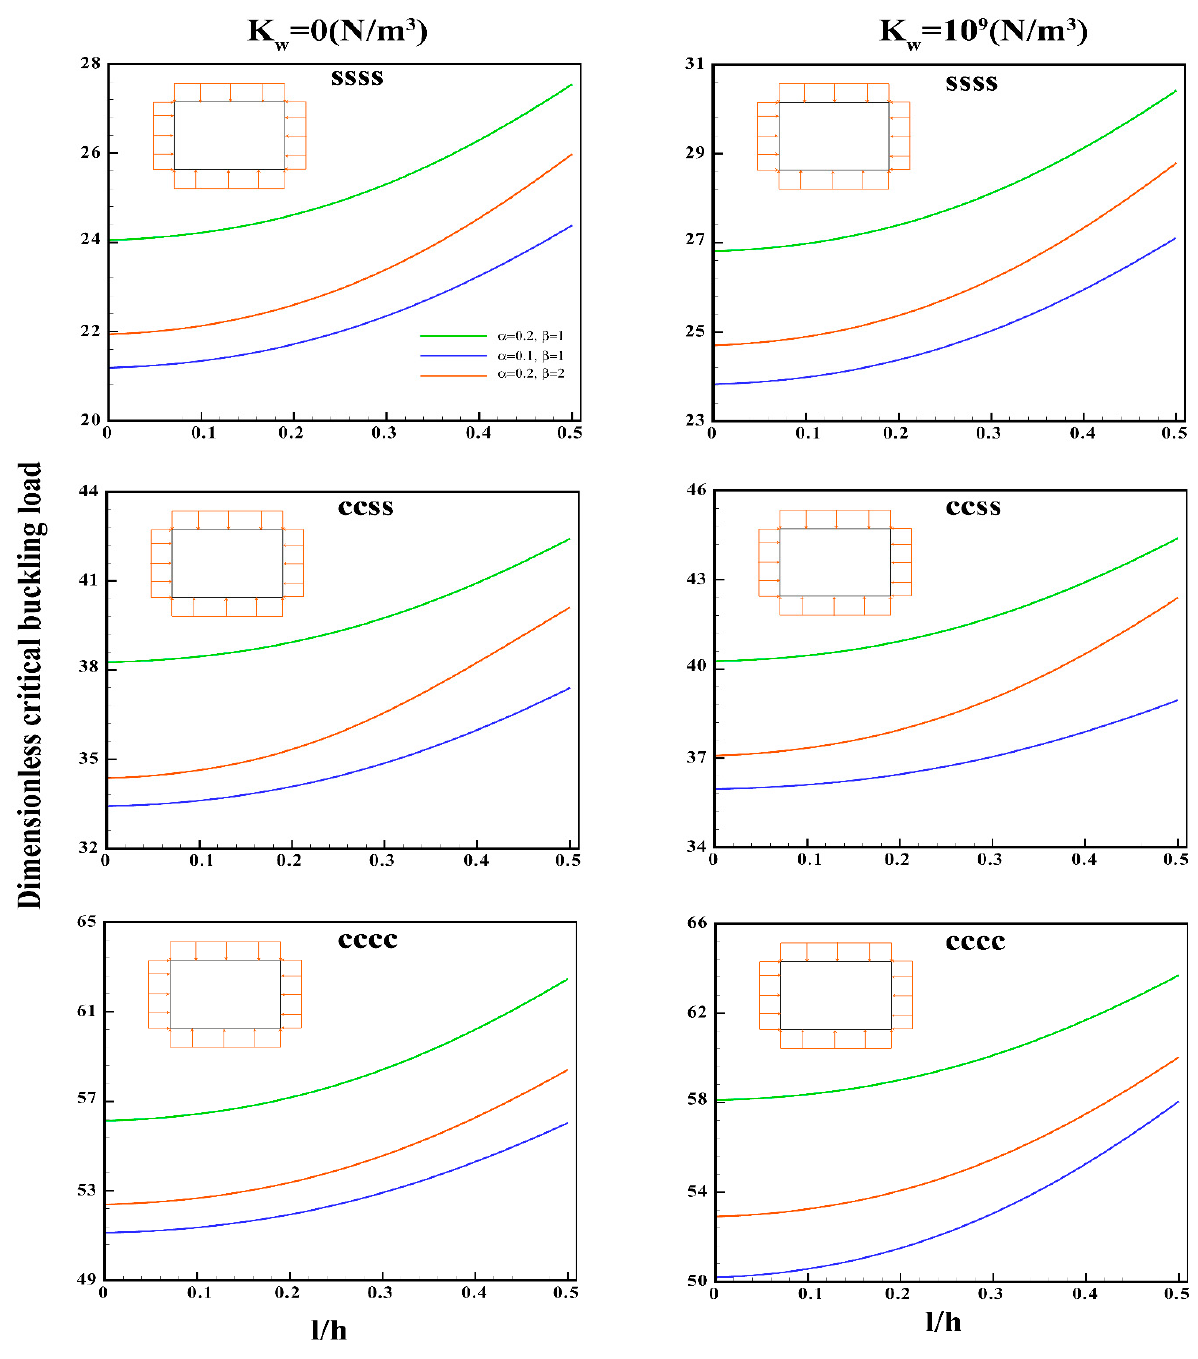
Figure 3. Variations of the dimensionless biaxial buckling load of the UD-CNTRC microplate against the material length scale parameter to thickness ratio for different boundary conditions and different values of the elastic medium stiffness parameter (uniform edge compressive load).